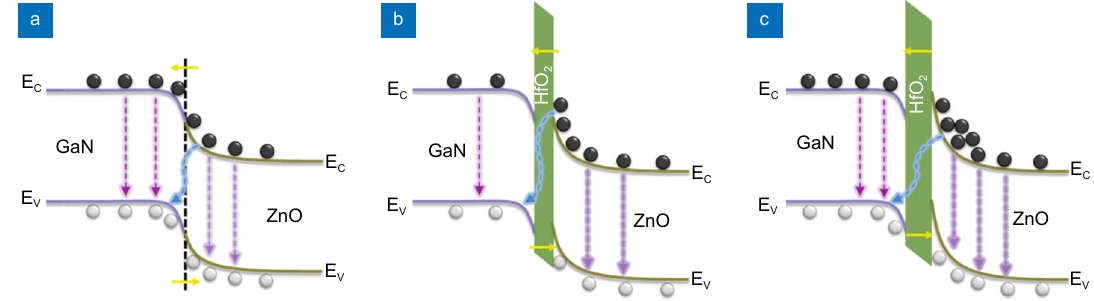
Fig. 8 | Schematic band structures of ( a ) ZnO/GaN, ( b ) ZnO /thin HfO 2 / GaN and ( c ) ZnO /thick HfO 2 /